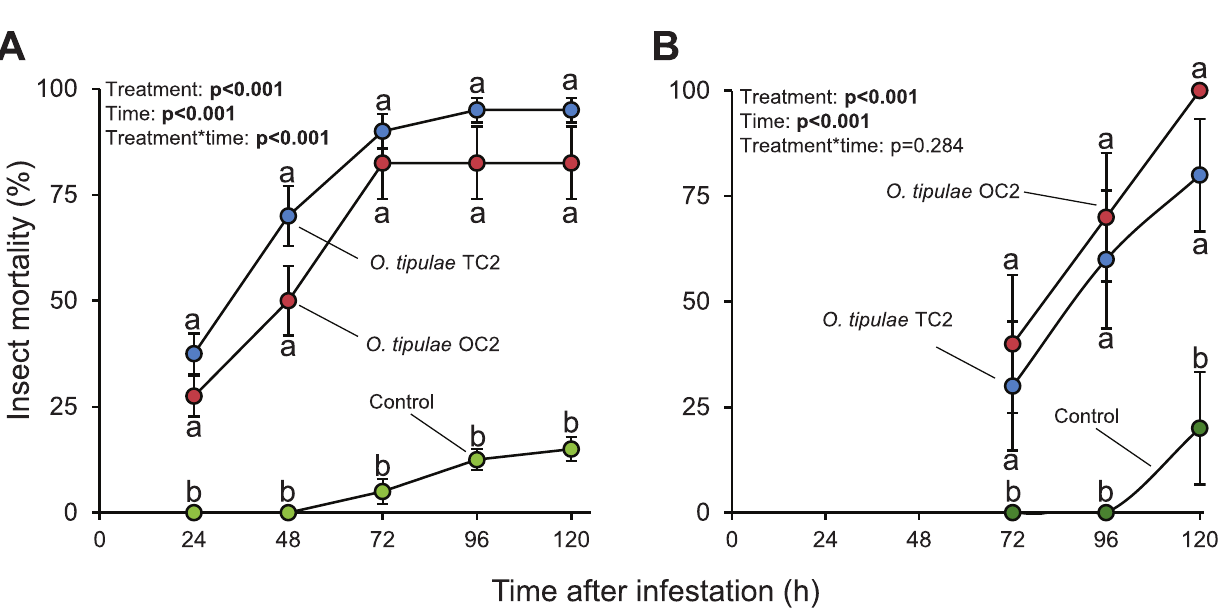
Fig 5. Mortality of G . mellonella upon infestation by O . tipulae nematodes. (A) and (B) Mean ( ± S.E.M.) mortality of G . mellonella larvae at different time points after applying 500 O . tipulae nematodes per larva. In experiment 1, four Petri plates with 10 larvae each were assayed (n = 4). In experiment 2, ten Petri plates with 10 larvae each were assayed (n = 10). Different letters indicate significant differences between treatments within time points (P < 0.05 by two-way repeated measures ANOVA with Holm’s multiple comparisons test).